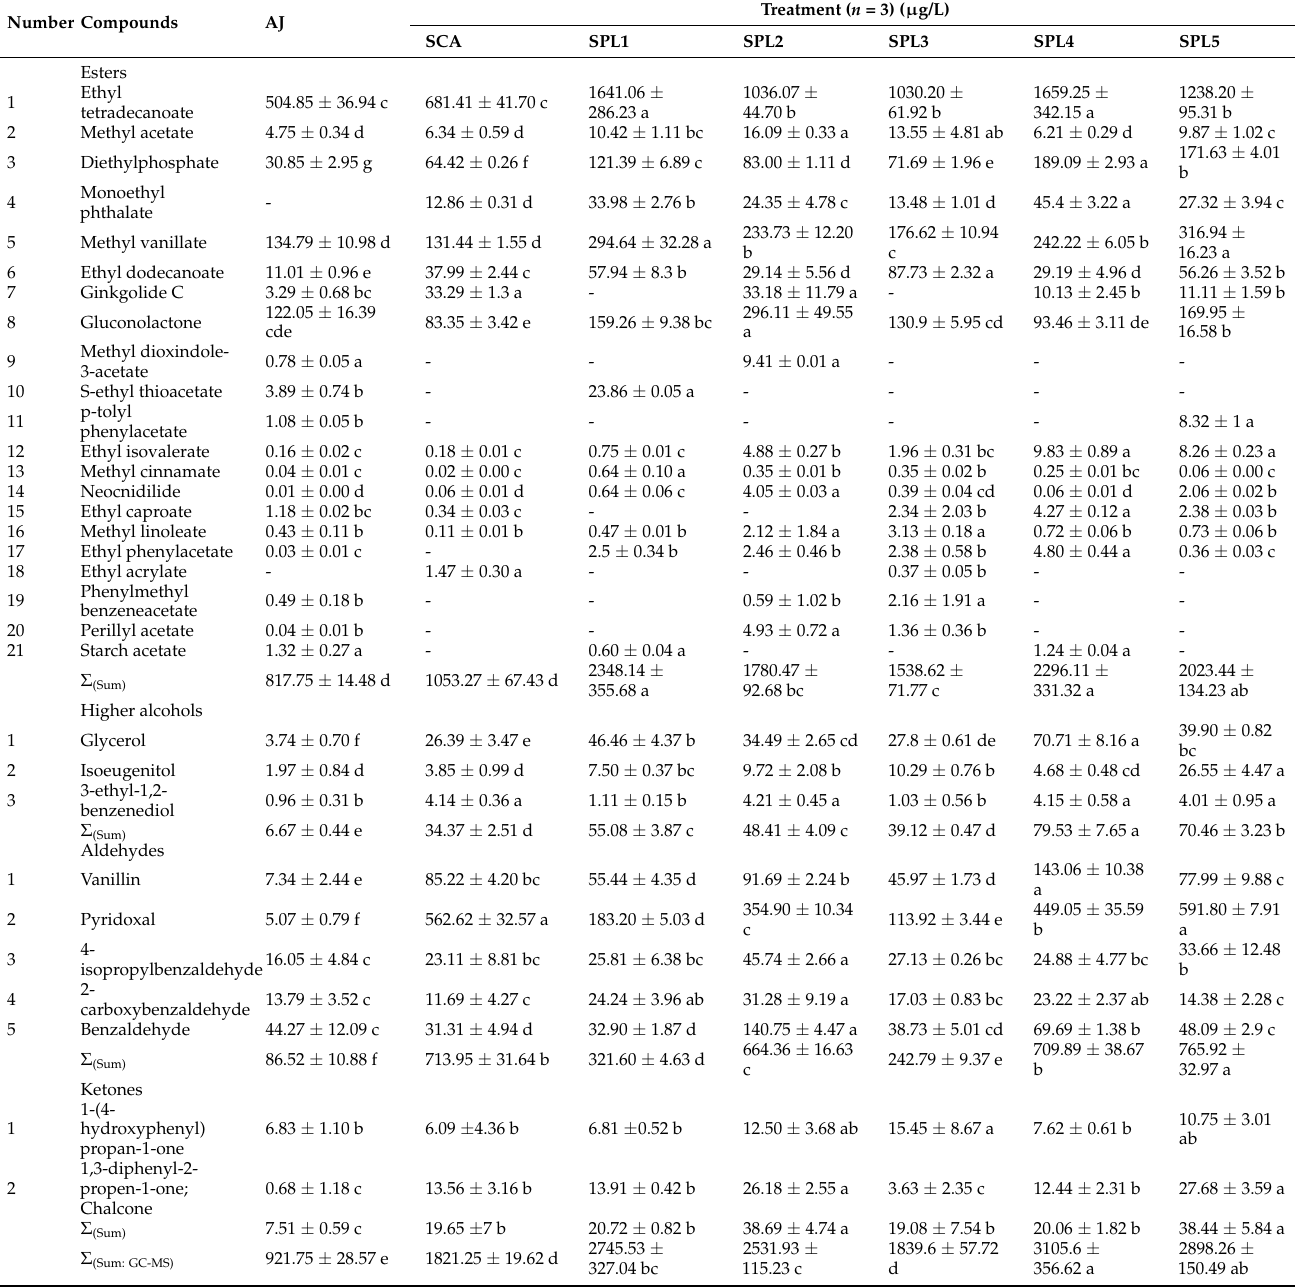
Table 2. Compounds determined by GC-MS in apple juice and ciders produced by single-culture and triple mixed-culture